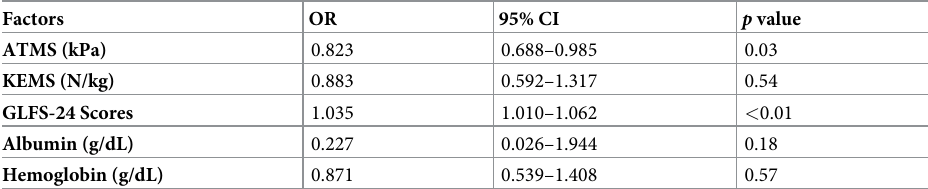
Table 3. Multivariate logistic regression analysis of the factors associated with